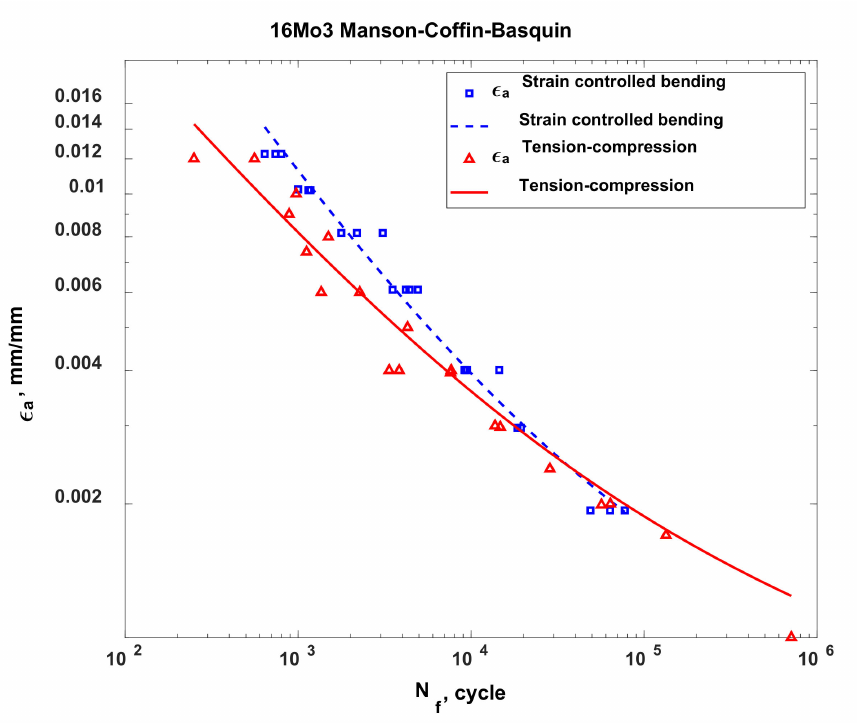
Figure 7. The strain characteristic for the 16Mo3 steel, developed for the cases of tension-compression and oscillatory